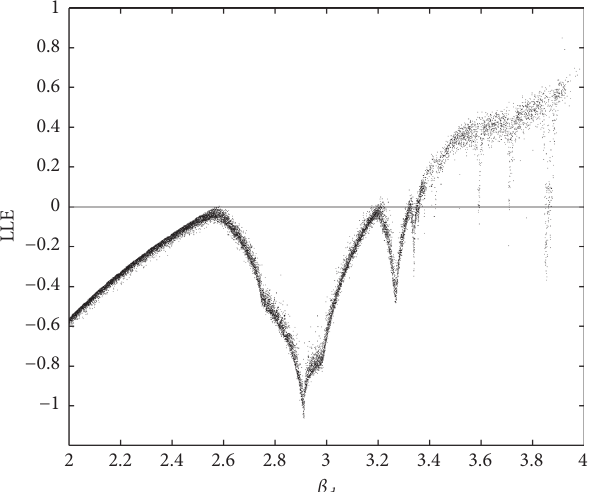
Figure 4: Largest Lyapunov exponent with respect to β β e � 0 .